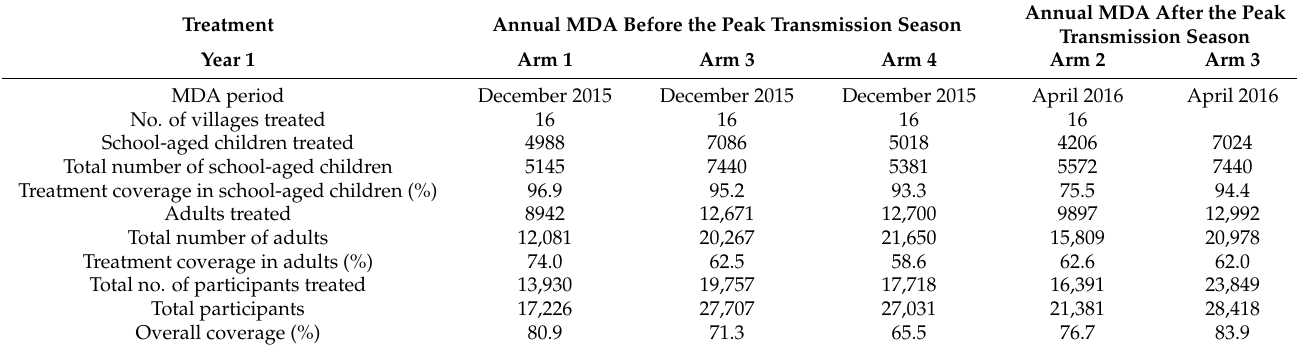
Table 4. Praziquantel coverage rate by treatment round by study arm for the first year intervention.